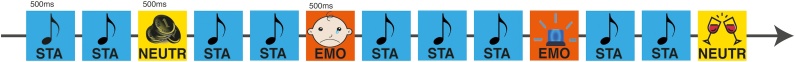
Sound sequence. Participants were instructed to ignore the oddball sound sequence and to focus on a silent video clip. Environmental sounds (EMO = emotional novel sounds; NEUTR = neutral novel sounds) were pseudo-randomly presented within a sequence of repeated standard sounds (STA). Examples of novel sounds are illustrated in the trial structure (chinking coins, a crying baby, a siren, toasting glasses, etc.). A total of 56 different novel sounds were presented with a randomized stimulus-onset asynchrony of 1800−2080 ms. Sounds were not relevant for the task (watching a video clip), but novel sounds were expected to capture attention.